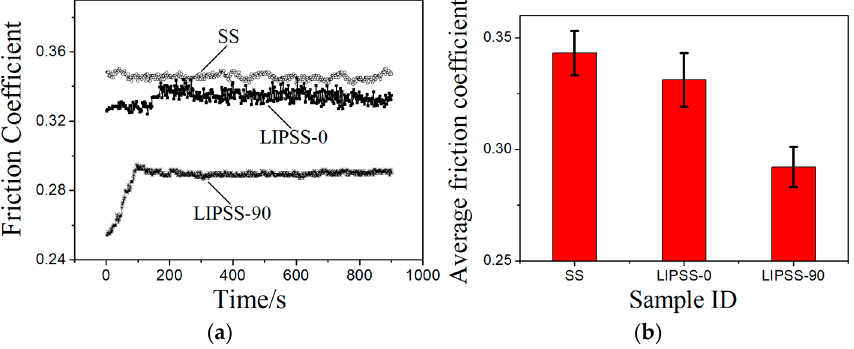
Figure 4. The results of friction test under the dry condition. ( a ) Variation of the friction coefficient with time; ( b ) Average friction coefficient.